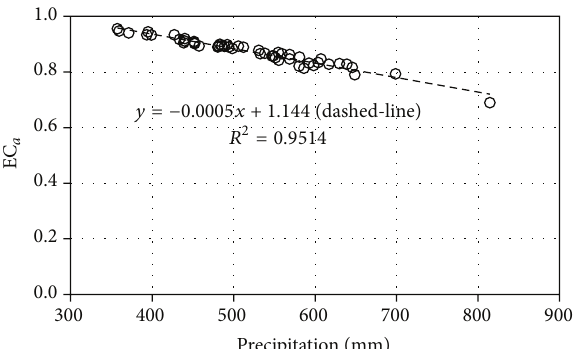
Figure 11: Relation between annual evapotranspiration coefficient and precipitation.